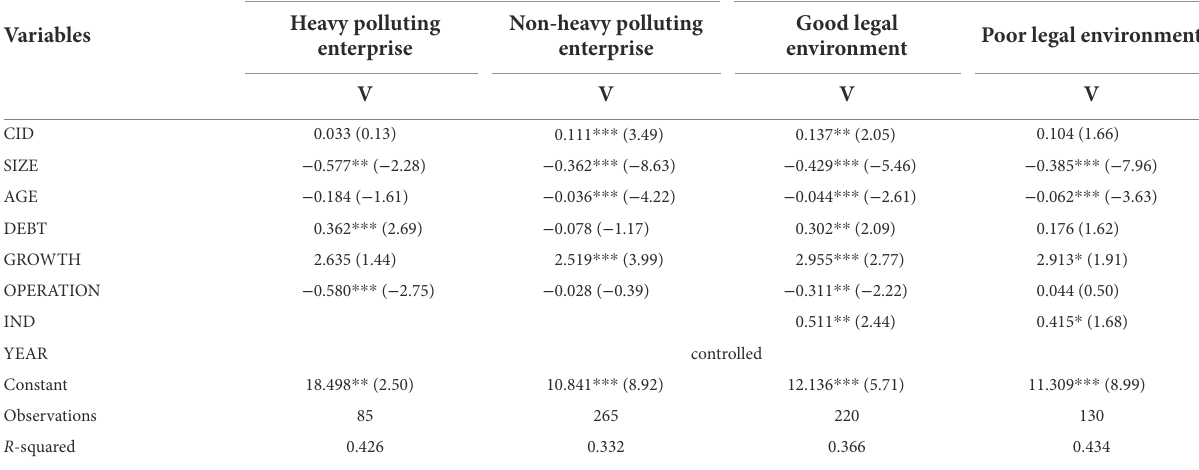
TABLE 15 Further